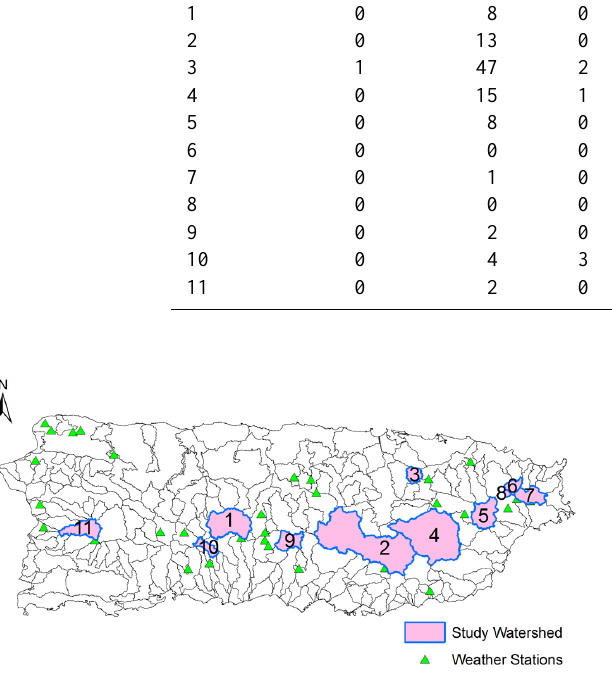
Fig. 1. Puerto Rico Island with NOAA weather stations (green triangles) and selected USGS monitoring stations (blue boundaries) for this study. Figure 1. Puerto Rico with NOAA weather stations (green trian- gles) and selected USGS monitoring stations (blue boundaries) for this